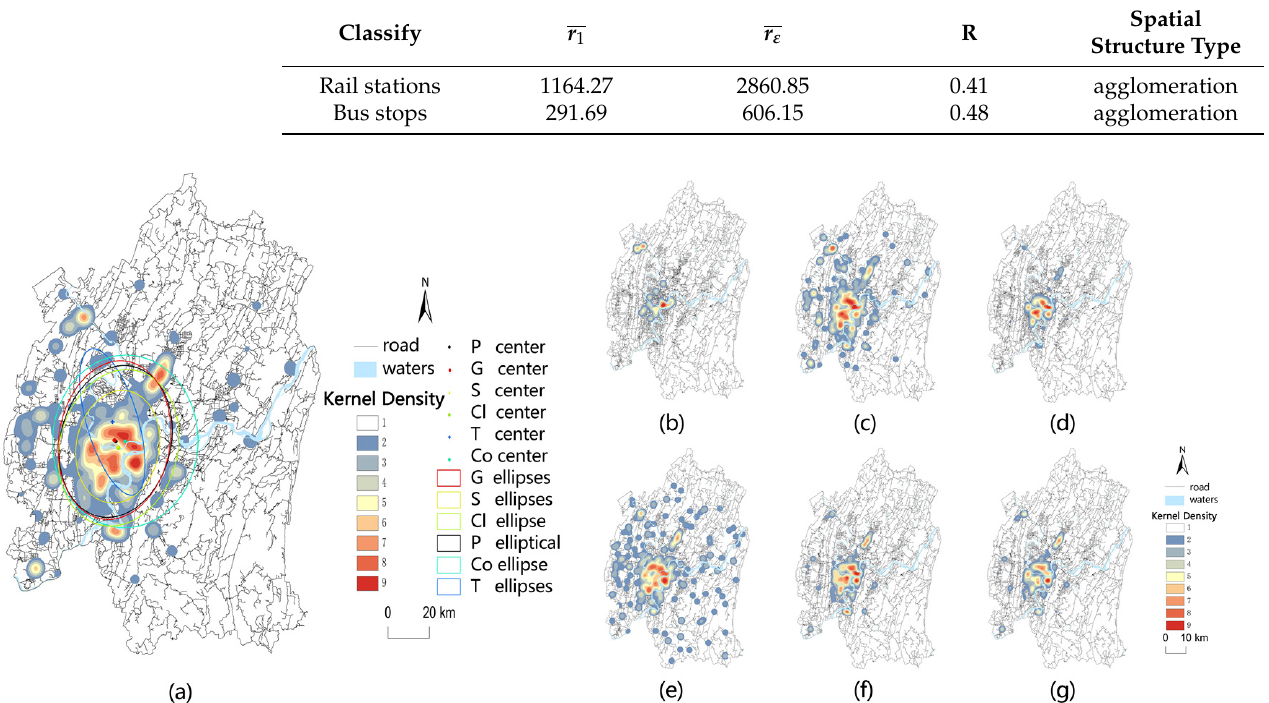
Figure 3. Kernel density analysis chart of various medical facilities: ( a ) general medical facilities; ( b ) tertiary grade A hospitals; ( c ) general hospitals; ( d ) specialist hospitals; ( e ) community-level hospitals; ( f ) clinics; ( g ) pharmacies.